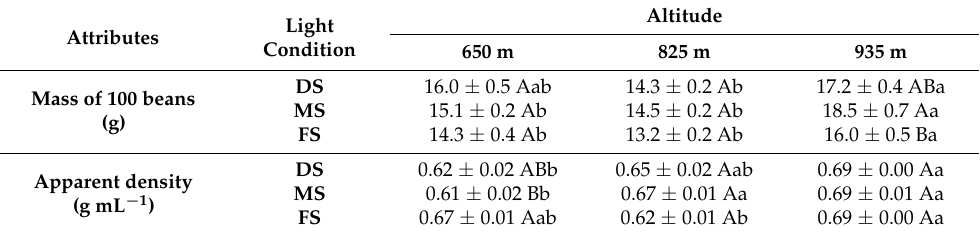
Table 3. Mass of 100 green coffee beans (g) and apparent density (g mL − 1 ) of green coffee beans obtained under three light exposure conditions (deep shade, DS; moderate shade, MS; full Sun, FS), and three altitudes (650 m, 825 m and 935 m).